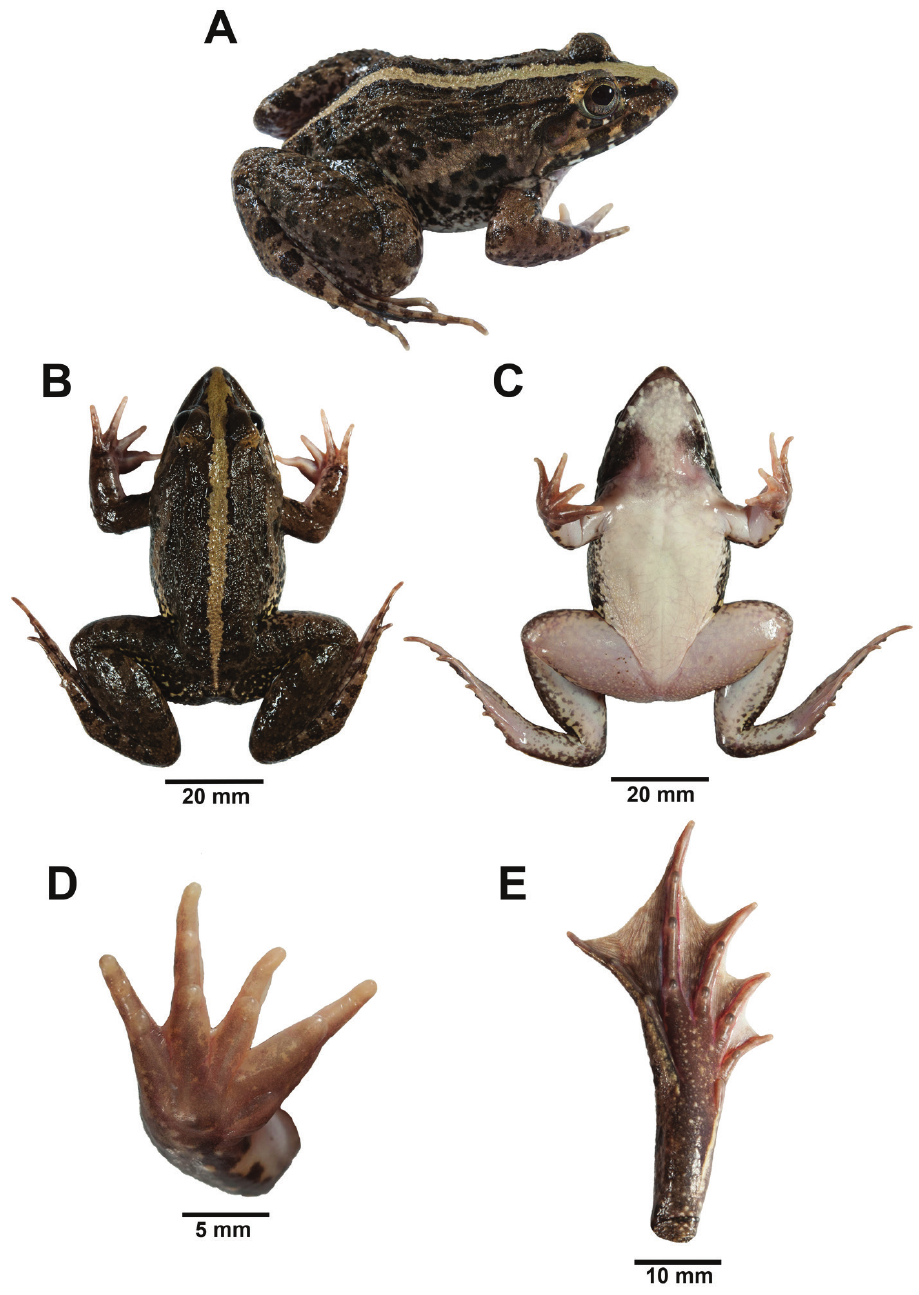
Figure 6. Adult male Fejervarya cancrivora (ZMKU AM 01426) from Khuan Khanun District, Phattha- lung Province, Thailand (SVL = 66. 9 mm) immediately prior to preservation in A right lateral B dorsal C ventral D right palmar, and E right plantar views. Photographs by Attapol